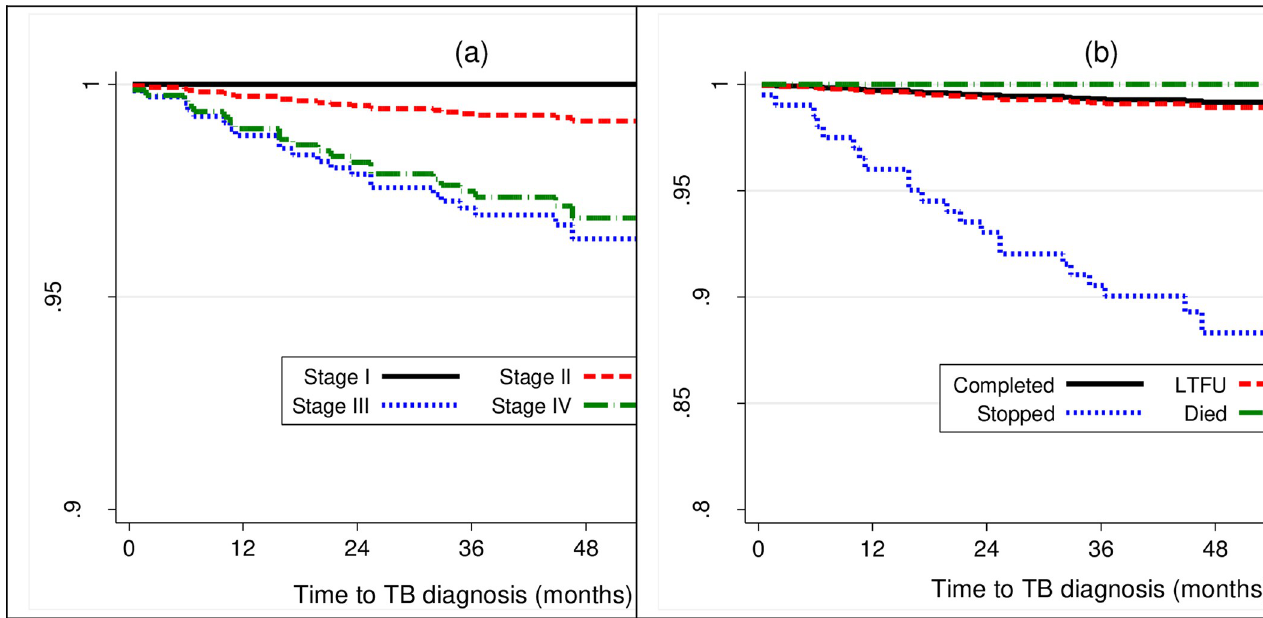
Fig 2. Shows probability of surviving TB disease, comparing WHO stages (panel a) and IPT outcomes (panel b) adjusted for clustering and other factors.